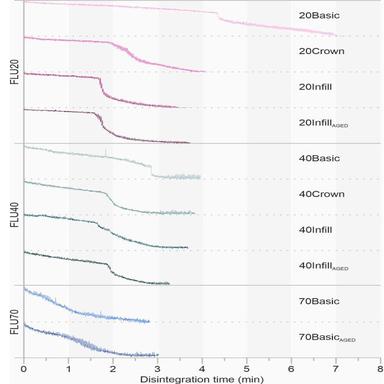
Changes in tablets' heights during disintegration process determined in the BJKSN-13 apparatus.